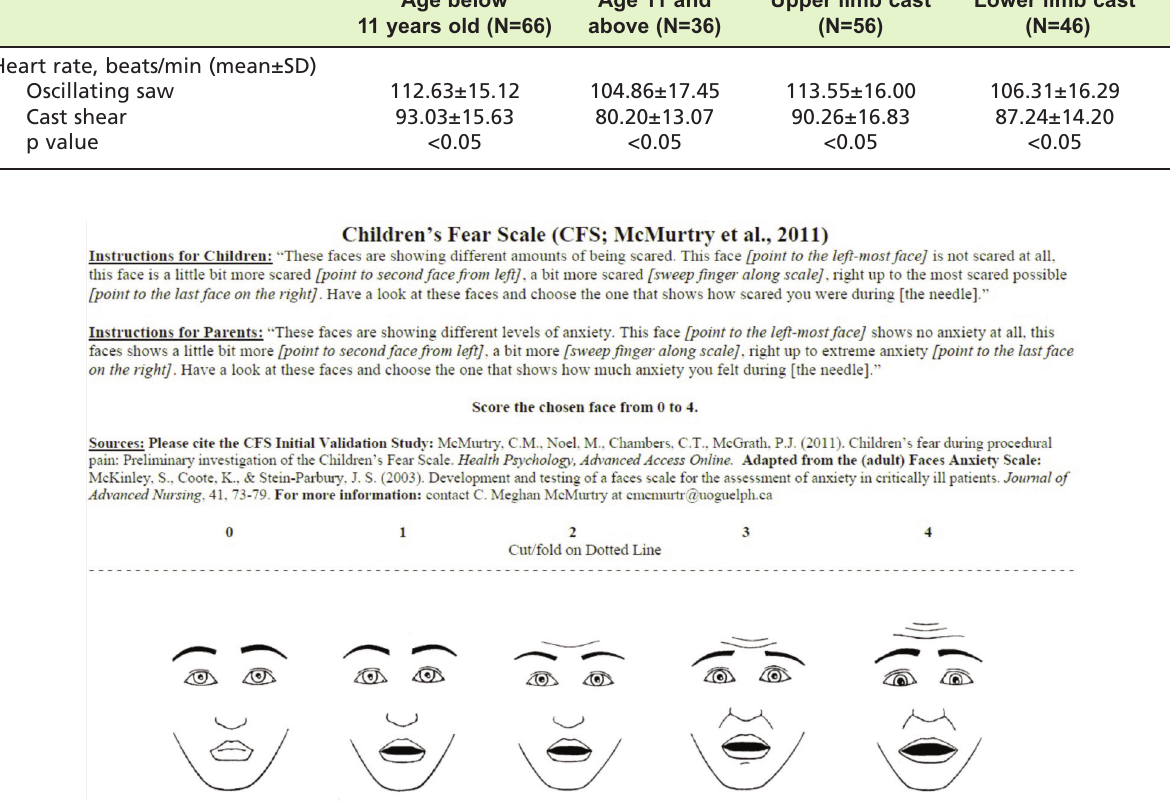
Children’s fear Fig. 1: